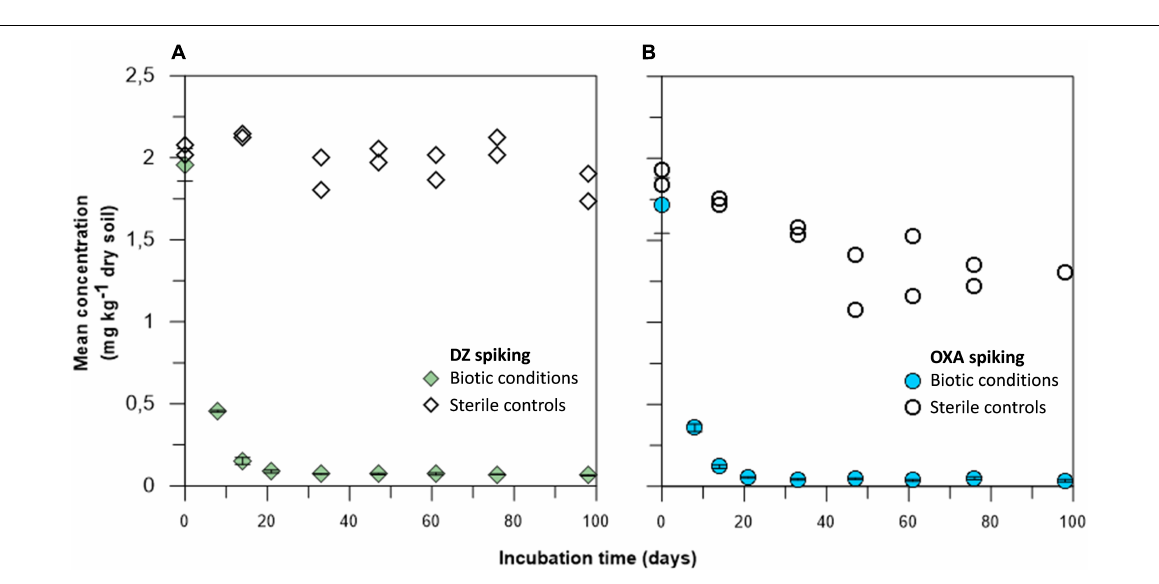
FIGURE 2 | Diazepam (DZ) (A) and oxazepam (OXA) (B) biodegradation kinetics over a 97-day period. Values for biotic conditions are presented as mean values of triplicates with standard deviations, and points for sterile controls are presented as sole values for both duplicates (see Figure 3 for